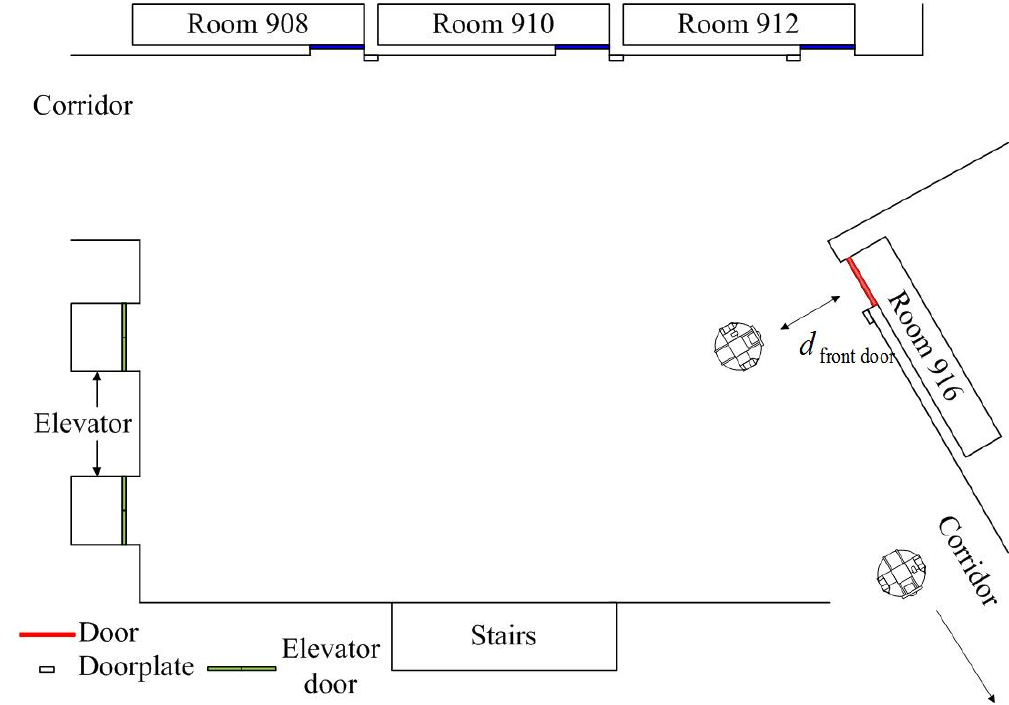
Figure 23. An ultrasonic sensor measures the distance between the robot and the door.